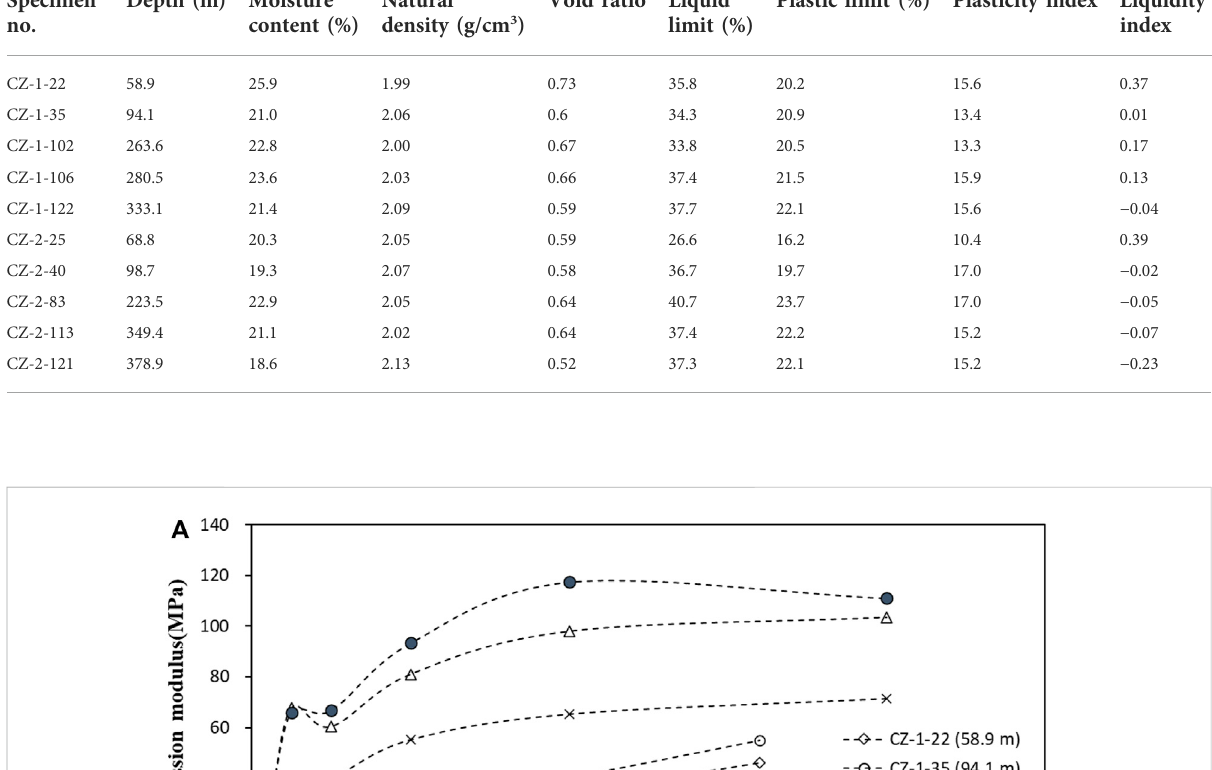
Frontiers in Environmental